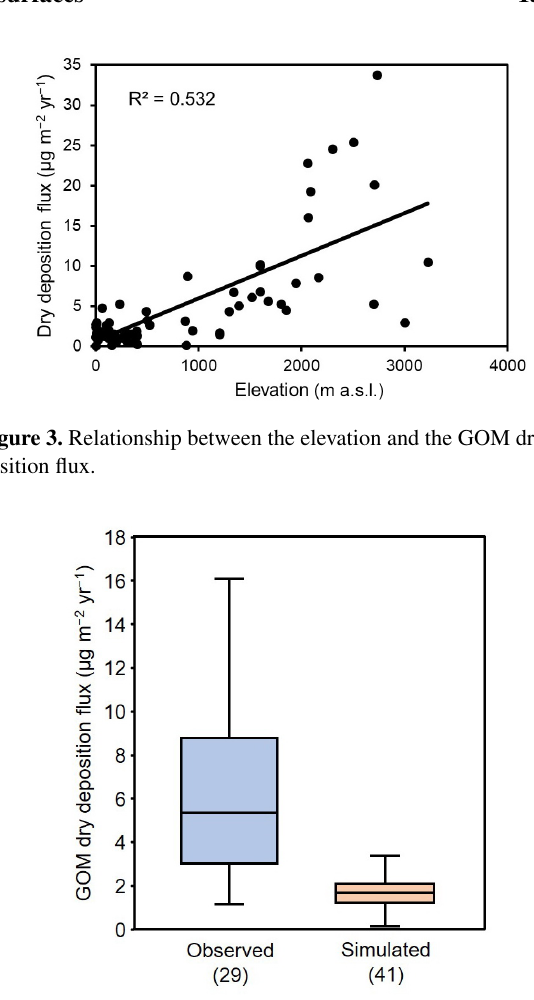
Figure 4. Comparison between the GOM dry deposition fluxes from direct observations and from model simulations based on measure- ments of GOM concentrations. The numbers in brackets stand for the numbers of